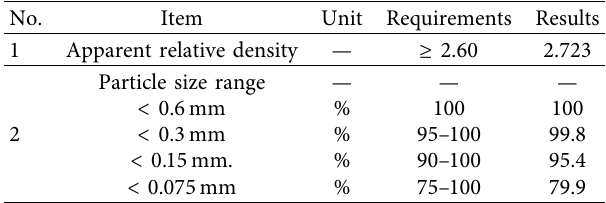
Table 4: Technical properties of limestone